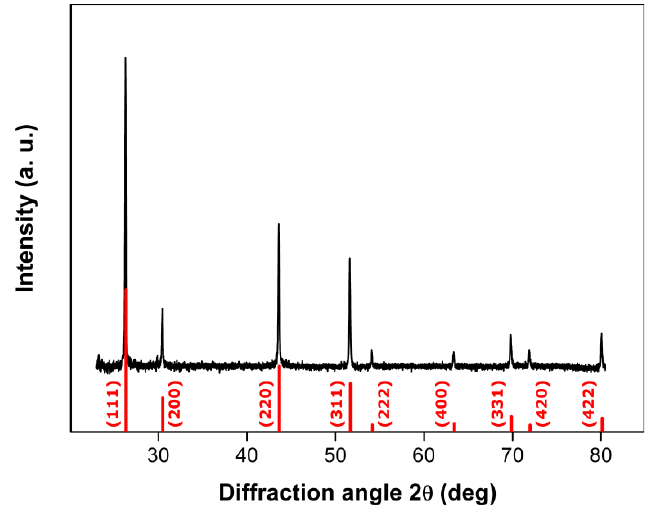
Figure 8. PXRD pattern of high aspect ratio ZB-type NWs grown at 400 °C from InP/Zn sources (reference pattern: ICSD 73-1983).